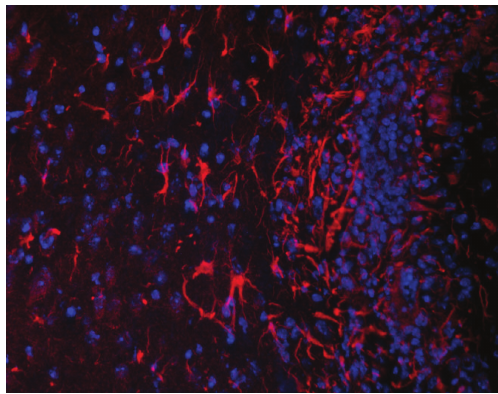
Figure 3: IDO-expressing astrocytes at the margin of a murine intracerebral GL261 glioma. IDO (red); nuclear counterstain